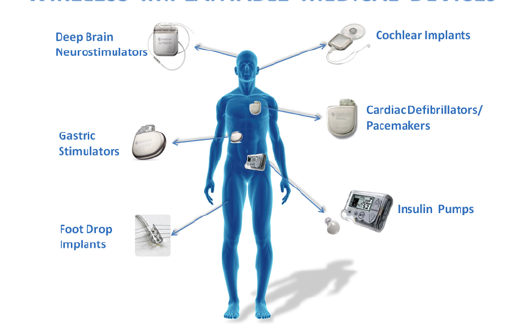
Figure 3. Example IoT medical devices on a patient’s